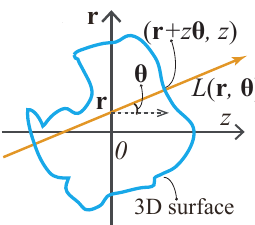
Figure 6. A 3D object’s light field representation.